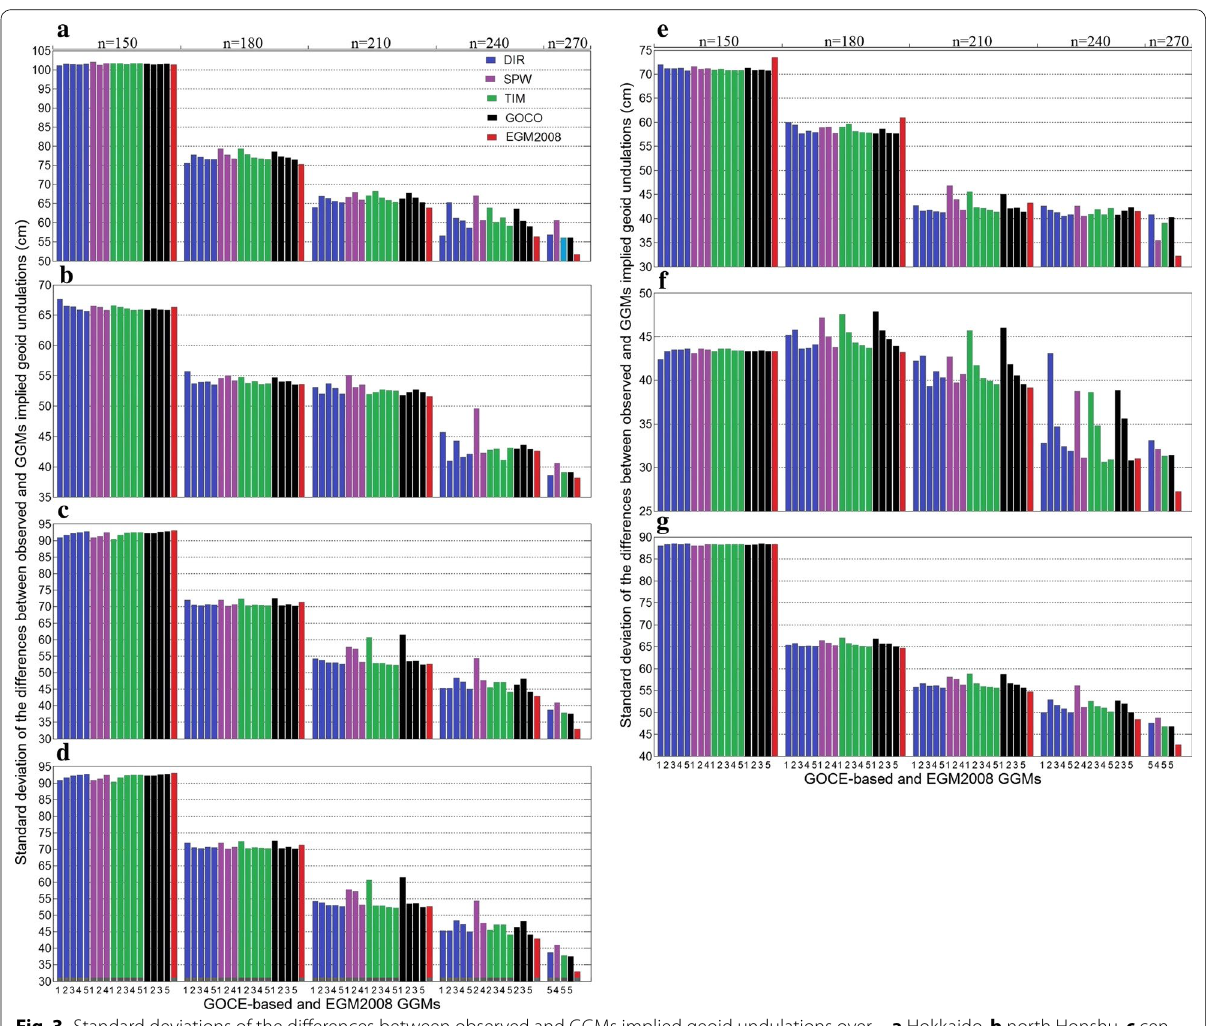
Fig. 3 Standard deviations of the differences between observed and GGMs implied geoid undulations over— a Hokkaido, b north Honshu, c cen- tral Honshu, d west Honshu, e Shikoku, f Kyushu and g Japan. n represents the spherical harmonic